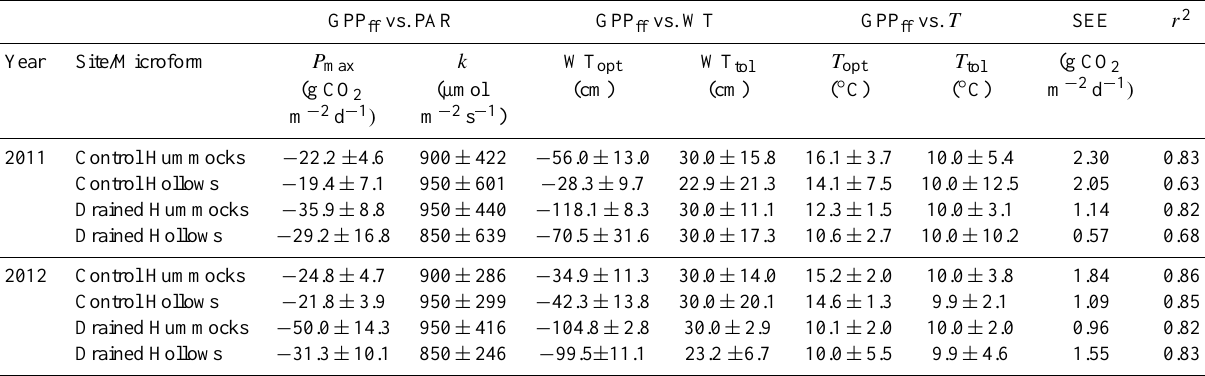
Table 1. Estimated parameter values ( ± SE), standard error of the estimate (SEE) and goodness of fit ( r 2 ) for the gross primary production of forest floor (GPP ff ) Model (Eq. 1) ∗